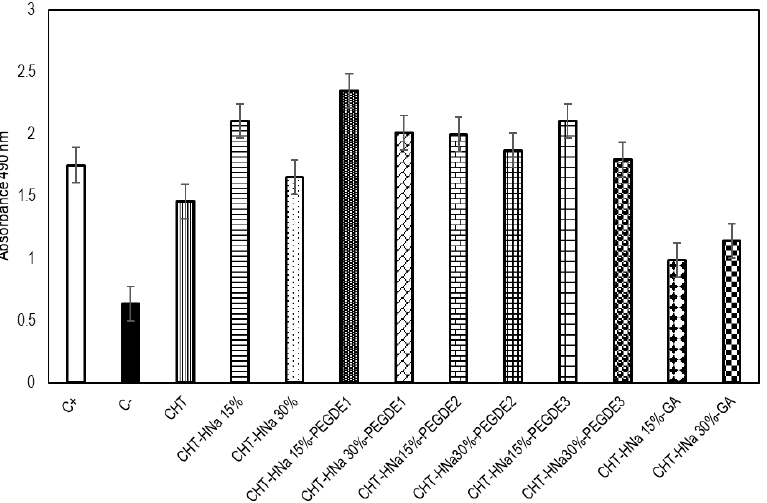
Figure 7. Viability of osteoblast with Chitosan (CHT), Chitosan and HNa (CHT/HNa), glutaralde- hyde crosslinked chitosan/HNa (CHT-HNa-GA), PEDGE crosslinked chitosan/HNa (CHT-HNa- PEDGE) at 15% and 30% of HNa.